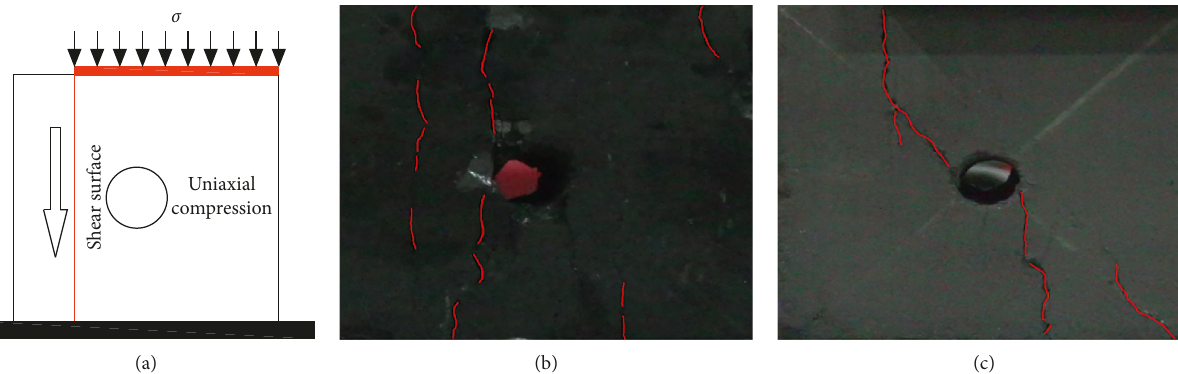
Figure 15: Samples crack evolution conditions under local load (3S/4). (a) Mechanical model; (b) coal sample; (c) briquette sample.